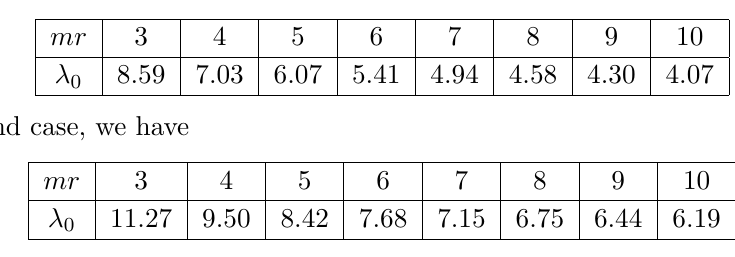
and f overlap, the defect has exp D